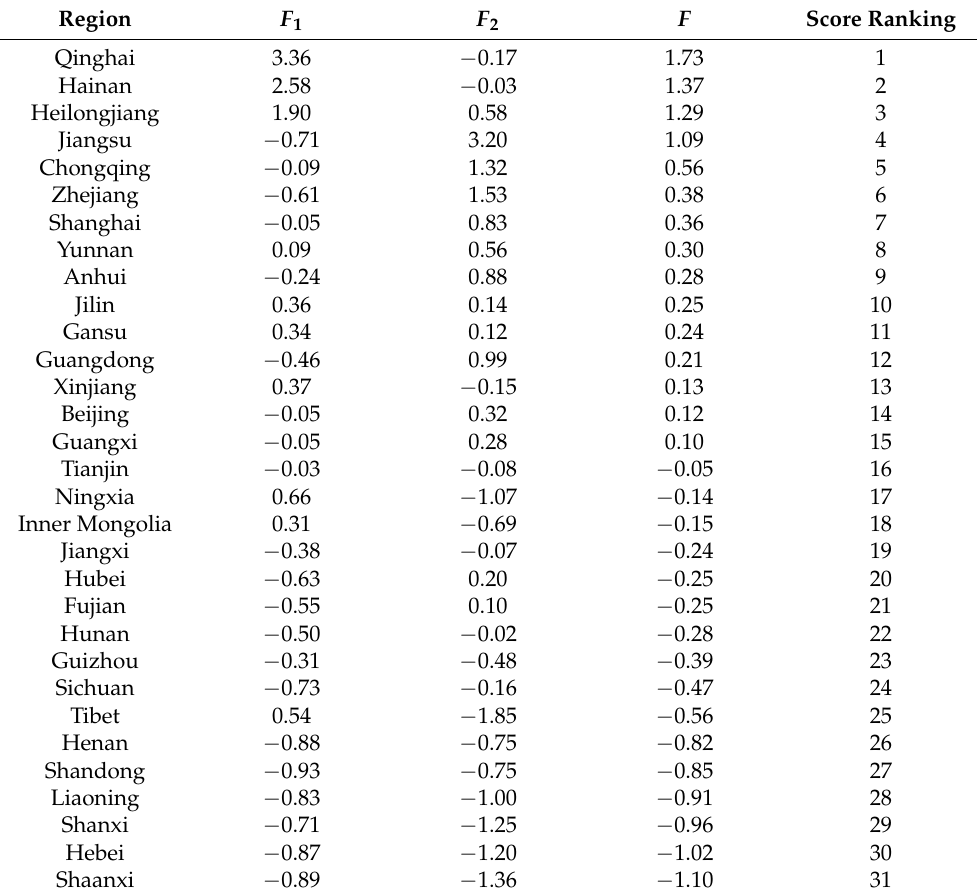
Table 3. Construction Accidents in 31 Regions (2010 to